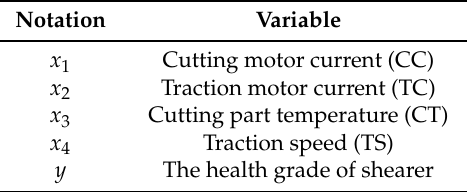
Table 1. The notations of variables.